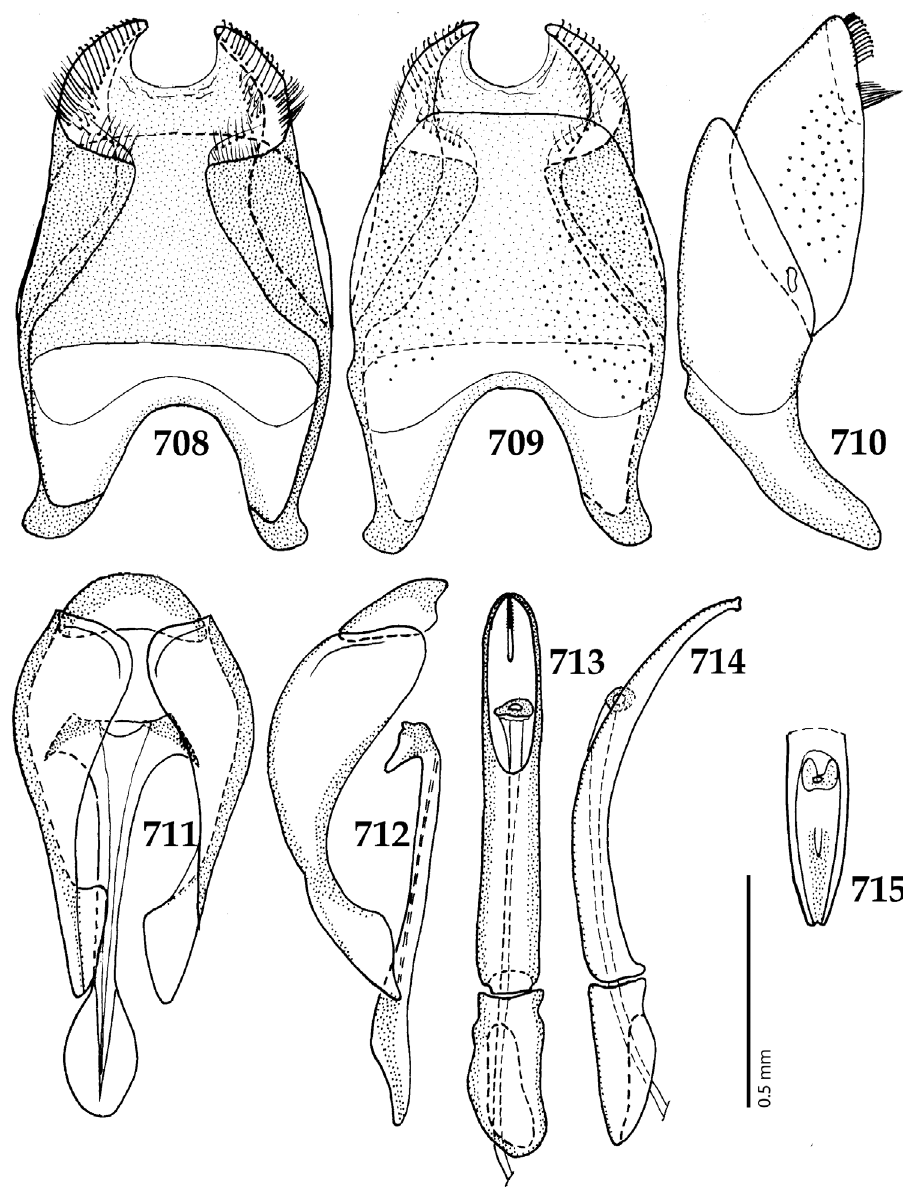
Figures 708–715. 708 Tomogenius motocola Mazur, 1990 male terminalia: 8 th sternite + 8 th tergite, ventral view 709 ditto, dorsal view 710 ditto, lateral view 711 male terminalia: 9 th + 10 th tergites, dorsal view; spiculum gastrale, ventral view 712 male terminalia: 9 th + 10 th tergites; spiculum gastrale, lateral view 713 male terminalia: aedeagus, dorsal view 714 ditto, lateral view 715 male terminalia: apex of aedeagus, frontal